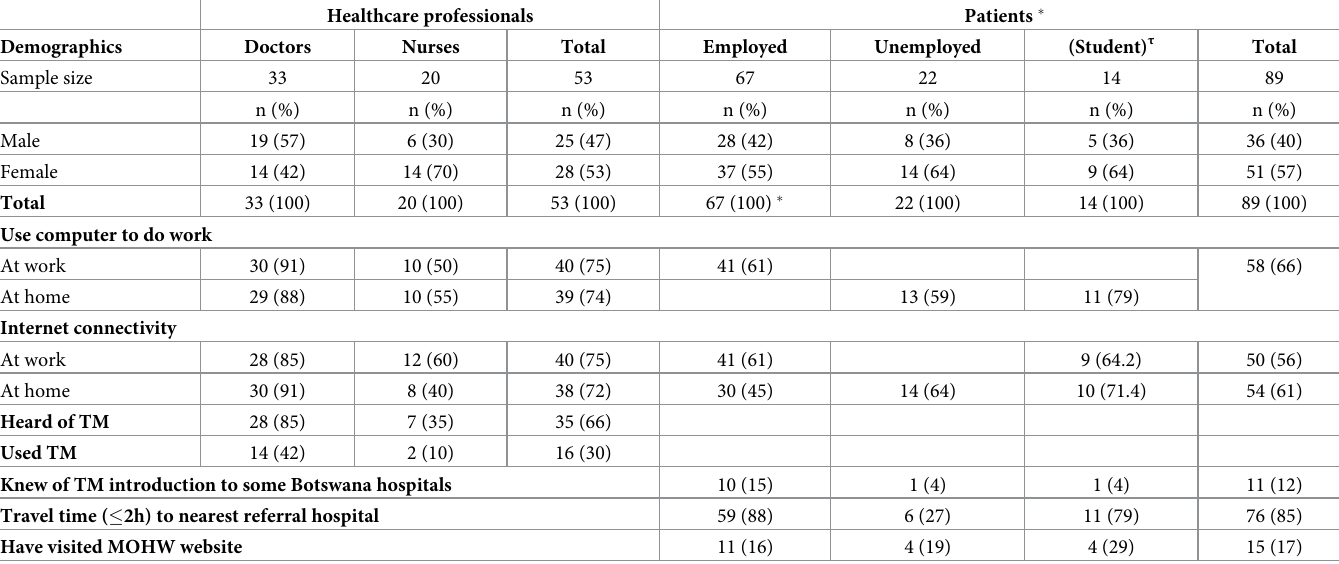
Table 1. Demographic characteristics and context (awareness and use of technology) of healthcare professionals and